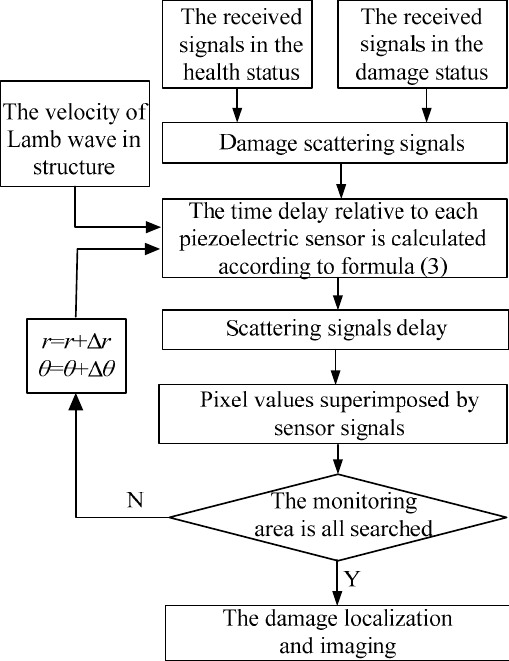
Figure 3. Flowchart of the near-field sampling ultrasonic phased-array damage imaging monitoring process.